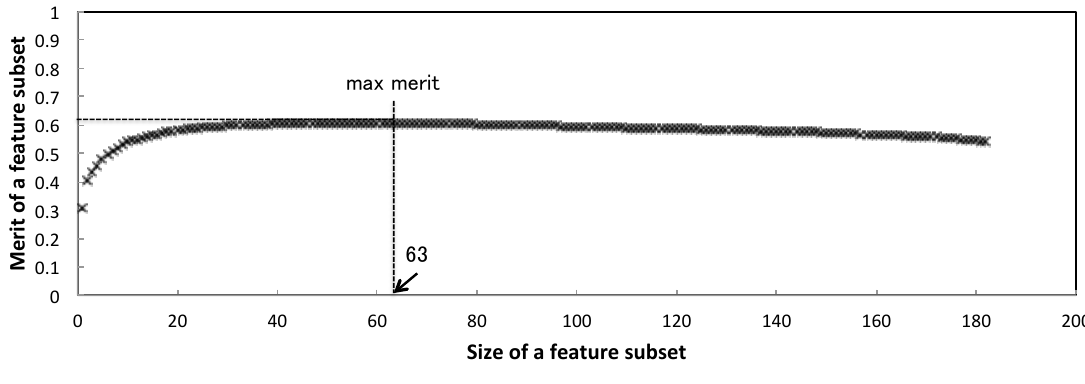
Figure 6. The relationship between the size of the feature subset and the merit score (window size: 256).